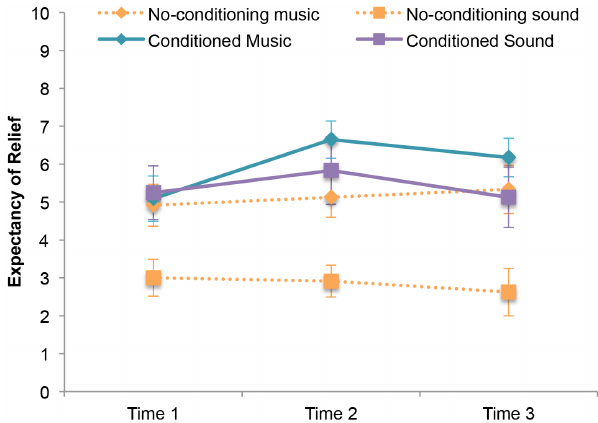
Figure 4. Average expectancy scores in all original groups, across all ERS assessment points . Means 6 SEM are shown for N=35. Time 1 occurs after verbal suggestion but prior to the conditioning phase in the conditioning groups, and prior to the matched variable pain phase in the no- conditioning group. Time 2 occurs immediately after the conditioning/variable pain phase, and Time 3 occurs after testing.